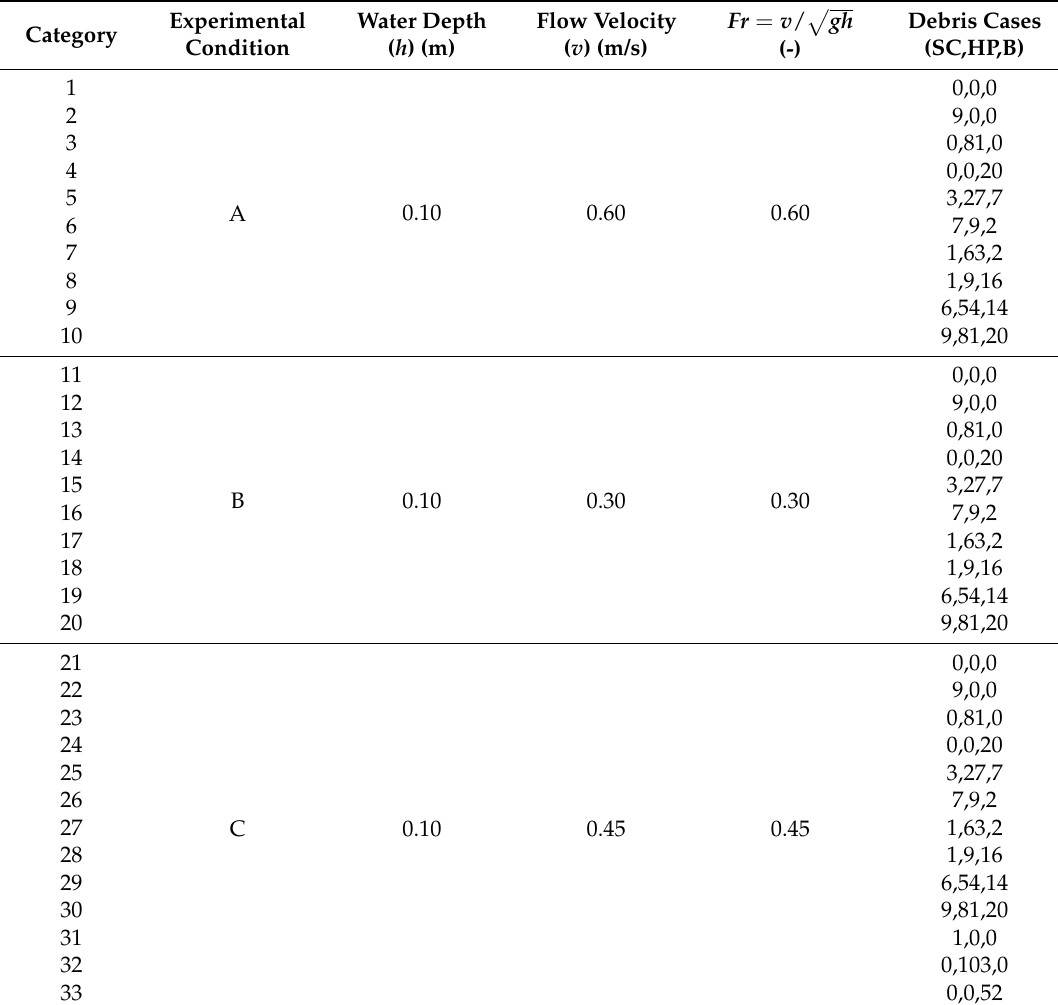
Table 3. Experimental